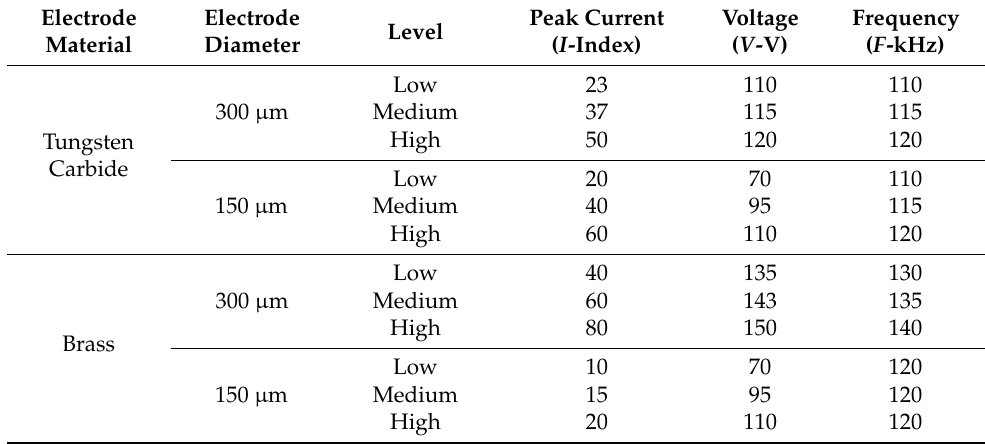
Table 3. Micro-EDM main process